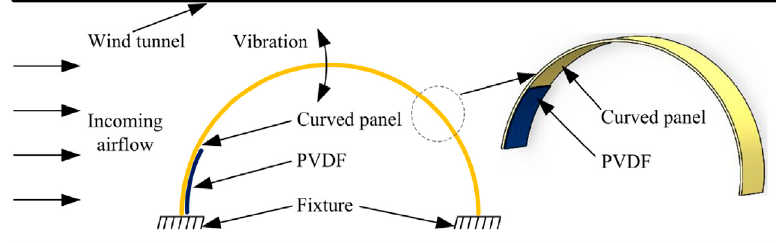
Figure 35. Scheme of the curved panel EH device concept [204].